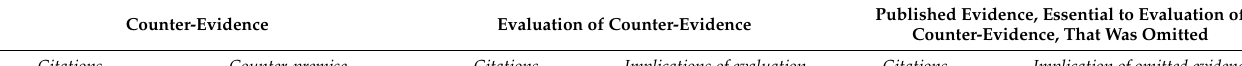
Table 4. Hagmann et al.’s table ([3] Table 4) about rates of fire is replicated in the left two columns, with omitted published evidence added in the right column, to show Hagmann et al. omitted published evidence and made incorrect conclusions as a